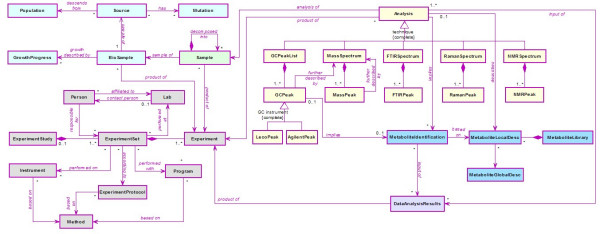


Detailed overview of MeMo. The detailed components of MeMo represented by UML classes.